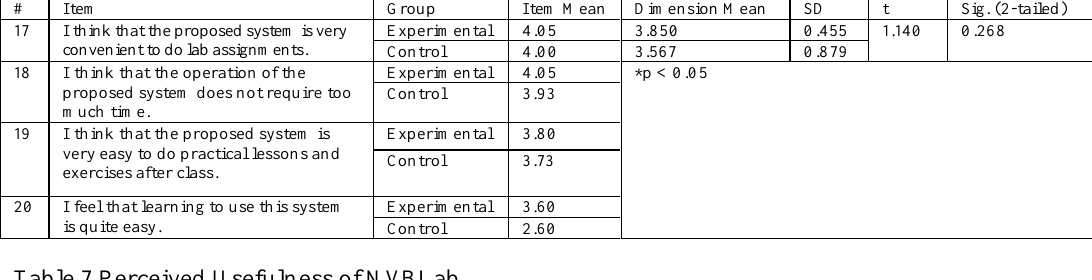
Table 7 Perceived Usefulness of NVBLab.